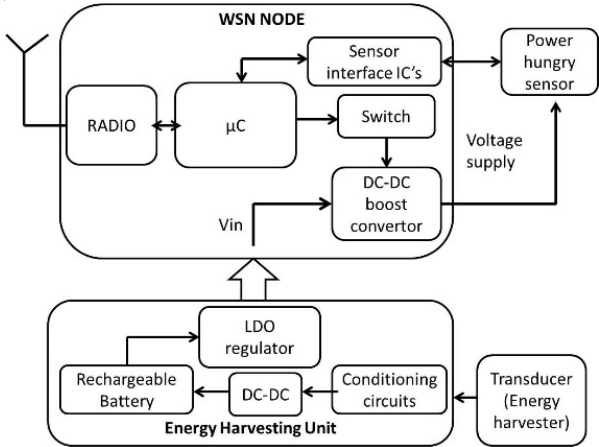
Figure 2. Generic block diagram of a WSN platform with an energy harvesting power unit and power hungry sensor.